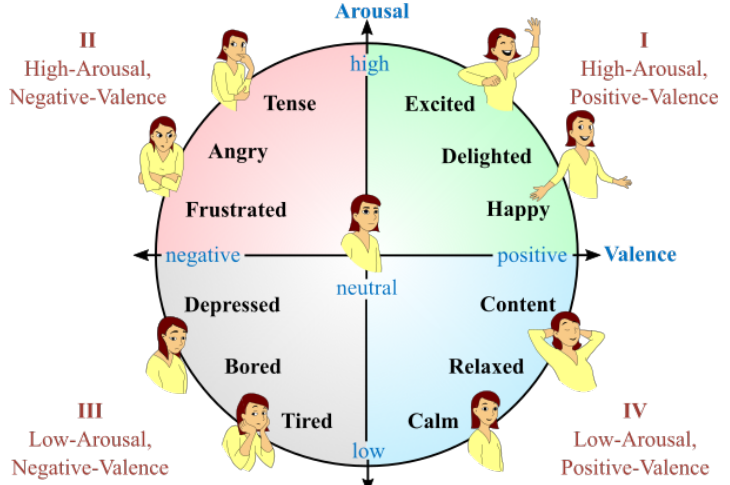
Figure 1. In Russell’s circumplex model, emotions are distributed on a two-dimensional plane. The x-axis represents valence and the y-axis represents arousal